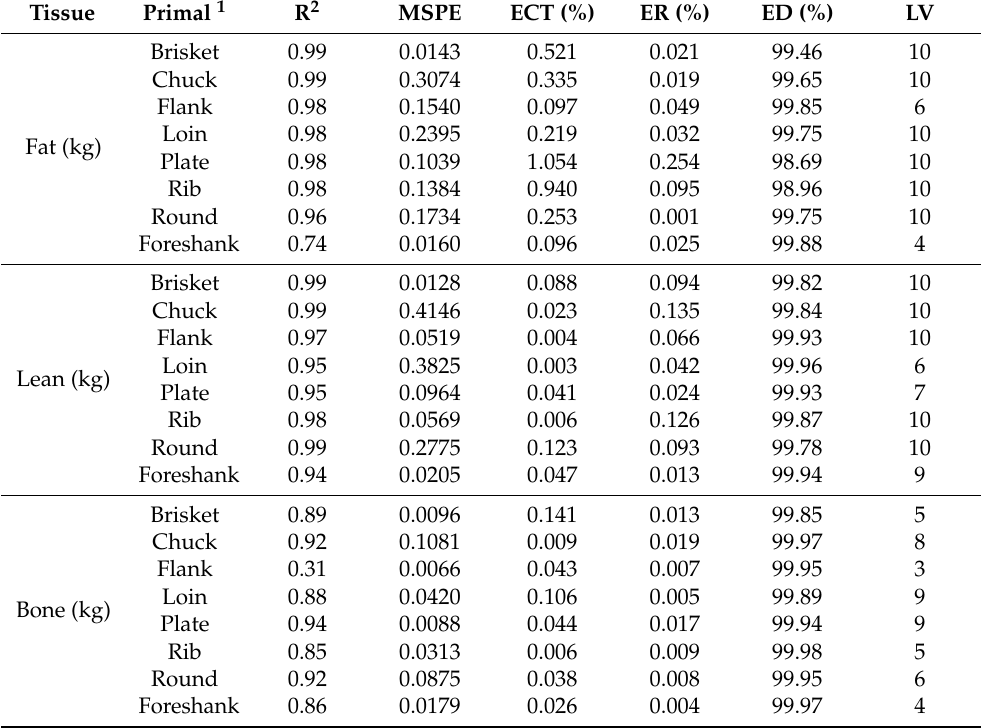
Table 3. Partial least square regression models estimating fat, lean, and bone for individual primal cuts from dual-energy X-ray absorptiometry (DXA) values (n = 111). Coefficient of determination (R 2 ), mean square prediction error (MSPE), error in central tendency (ECT), error due to regression (ER), error due to disturbances (ED), and the number of latent variables (LV) are presented for each